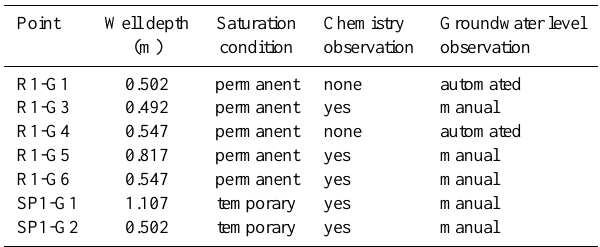
Table 2. Values of variation explained by principal components for six tracers in